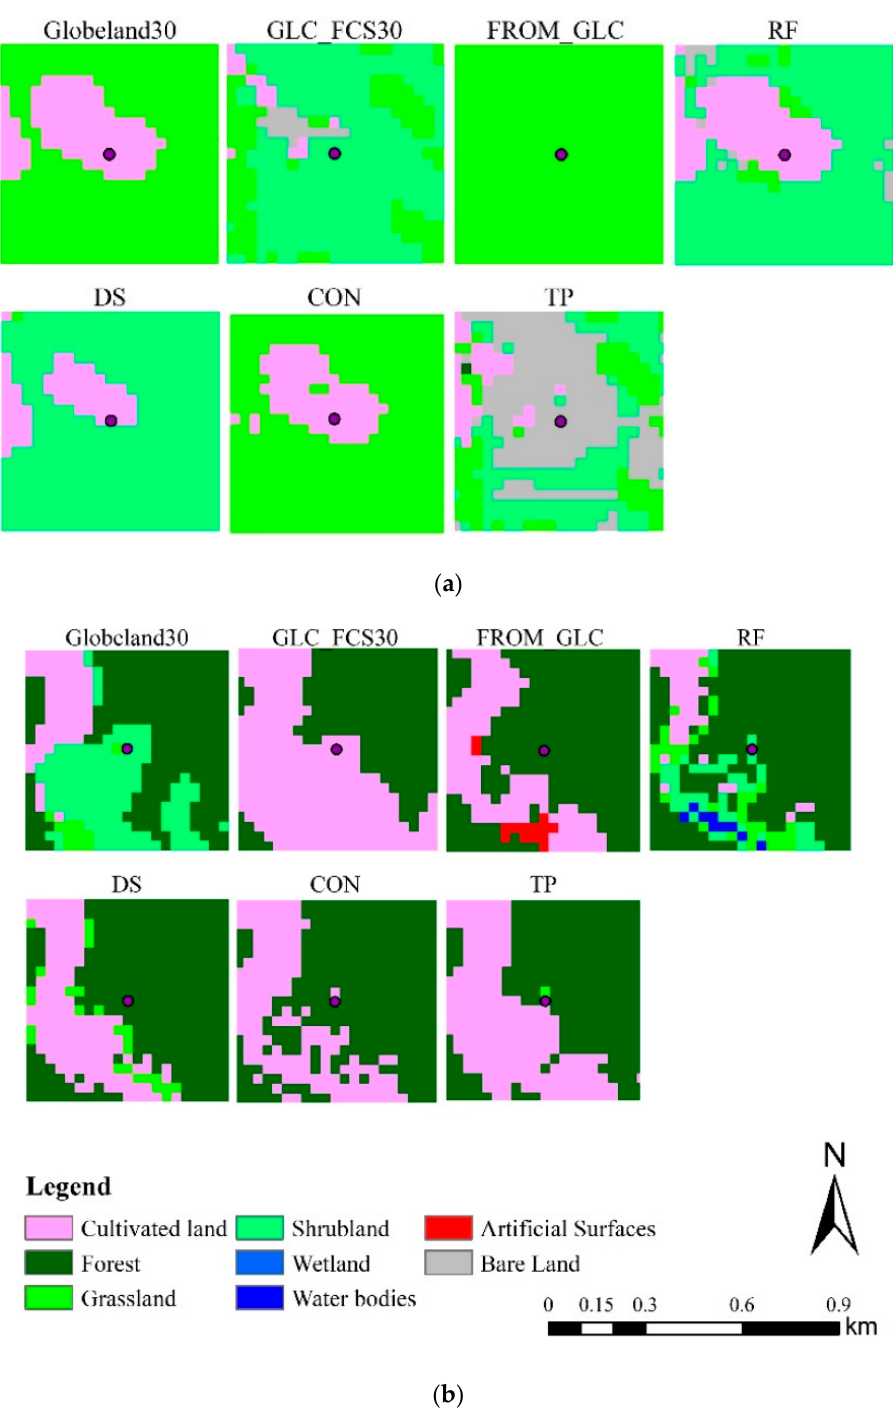
Figure 4. Subsets of base and fused products centered at: ( a ) sample unit A (2010) and ( b ) sample unit B (2020).